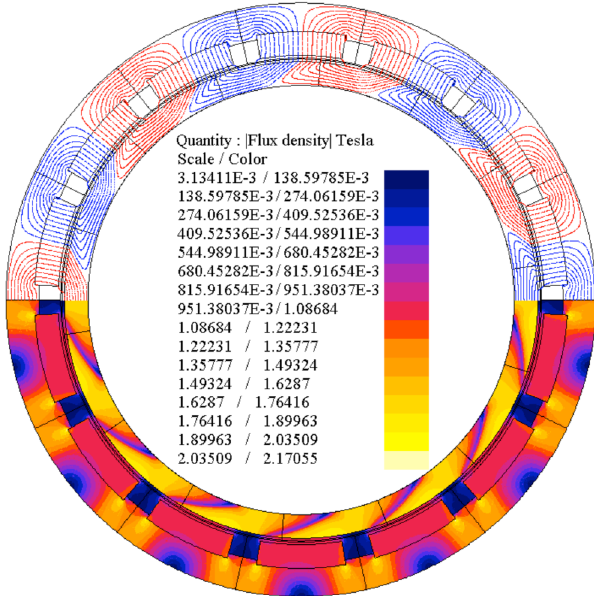
Fig. 3. Equi- fl ux lines and magnetic fl ux density distribution on the ORPMECH cross section.